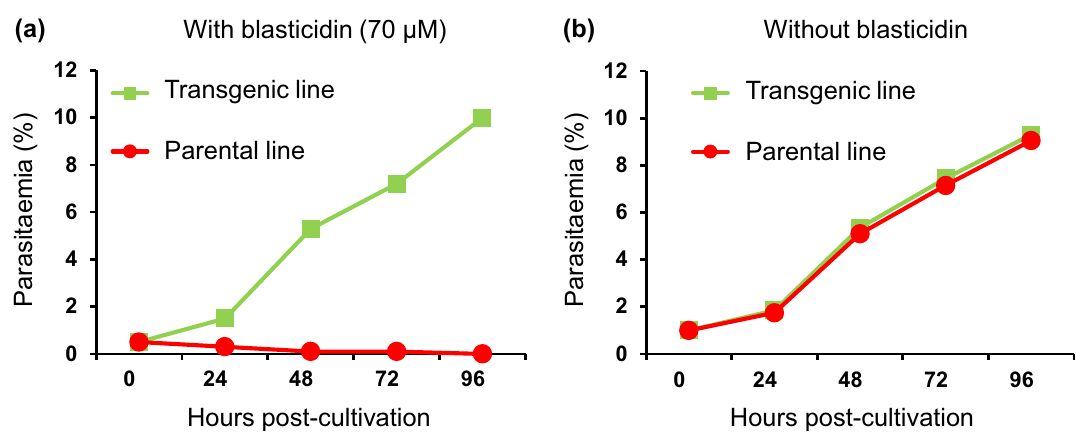
Figure 3. Parasitaemia curves of the transgenic T . equi line expressing enhanced green fluorescent protein/ blasticidin S deaminase (eGFP/BSD) and the parental line. ( a ) Transgenic T . equi was resistant to blasticidin but the parental line was not when cultured in medium containing 70-µM blasticidin. ( b ) The parasitaemia dynamics were comparable between the transgenic and parent lines when cultured in normal